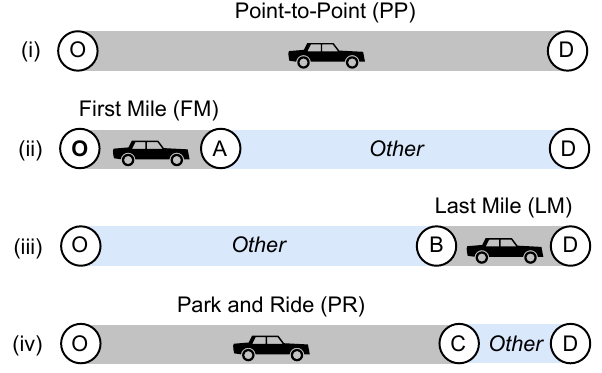
Figure 1. Different forms of car